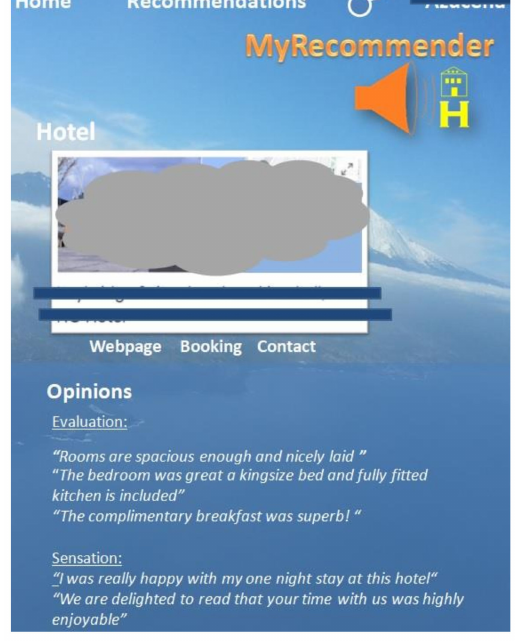
Figure 2. Recommended hotel and relevant sentences from user